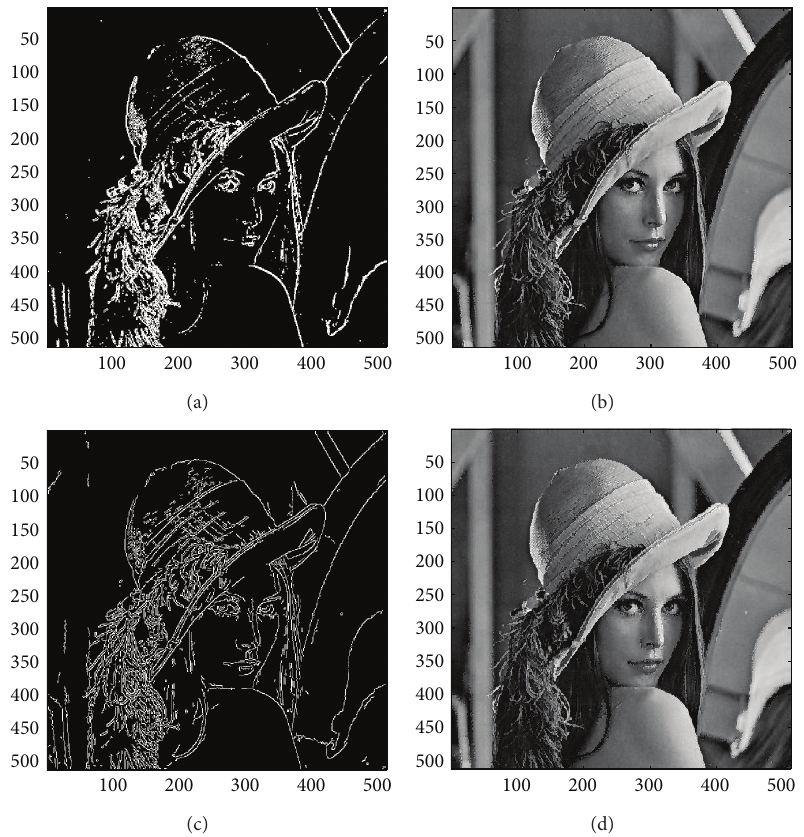
= 18 in the image “Lena.” (b) Result by HVD with scaling factor 𝑠 = 1.0 . (c) Edges detected Figure 13: (a) Edges detected by HVD with 𝜃 eth by Canny operator in the image “Lena.” (d) Result by Canny operator with scaling factor 𝑠 = 1.0 . Table 2: Operation counts of the proposed approach. Operations Low pass